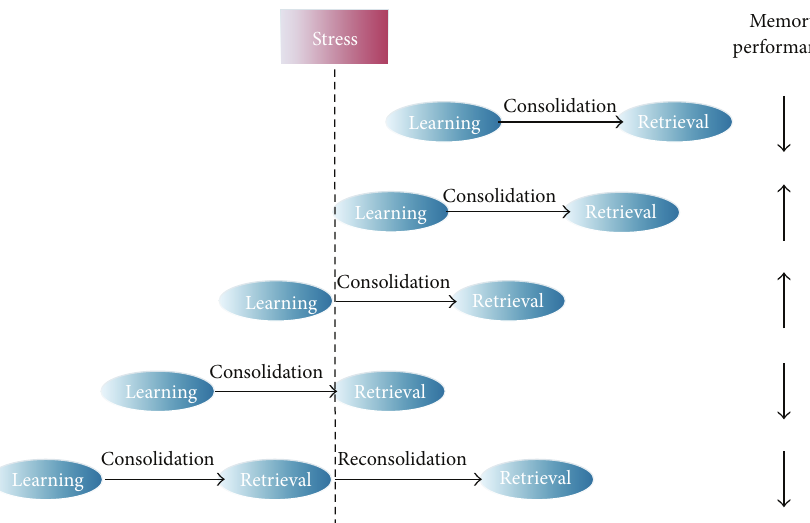
Figure 5: Stress affects memory performance in a different manner dependent on the timing of the stressor